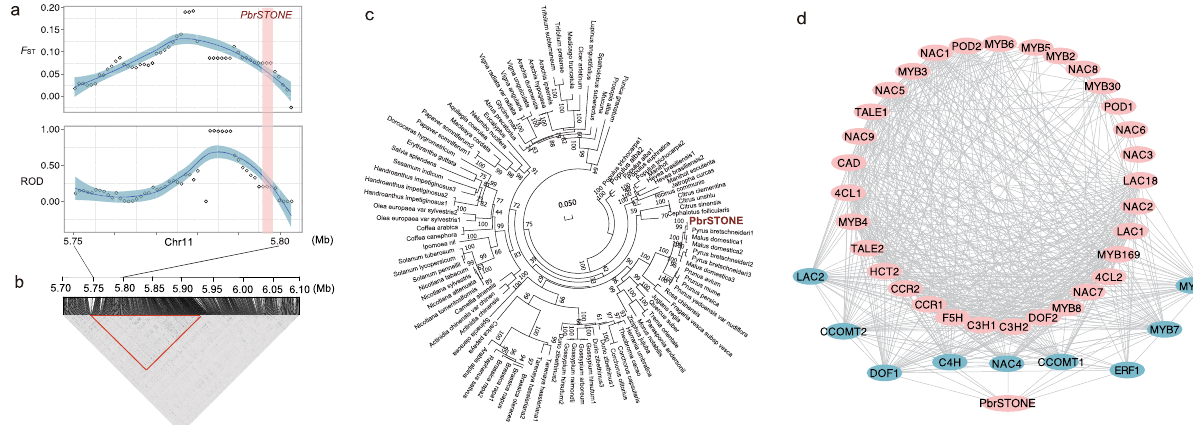
Fig. 4 Stone cell content-related gene PbrSTONE . a Distribution of F ST and ROD in the PbrSTONE gene region in landrace and improved groups. The shaded region in pink indicates the location of PbrSTONE , and the shade region in blue presents the smooth local regression by ‘ loess ’ . b LD in the PbrSTONE gene region. c Phylogenetic tree of homologous genes of PbrSTONE in 81 plant species. d Co-expression network of PbrSTONE with lignin related genes. Source data underlying ( c , d ) are provided as a Source Data fi